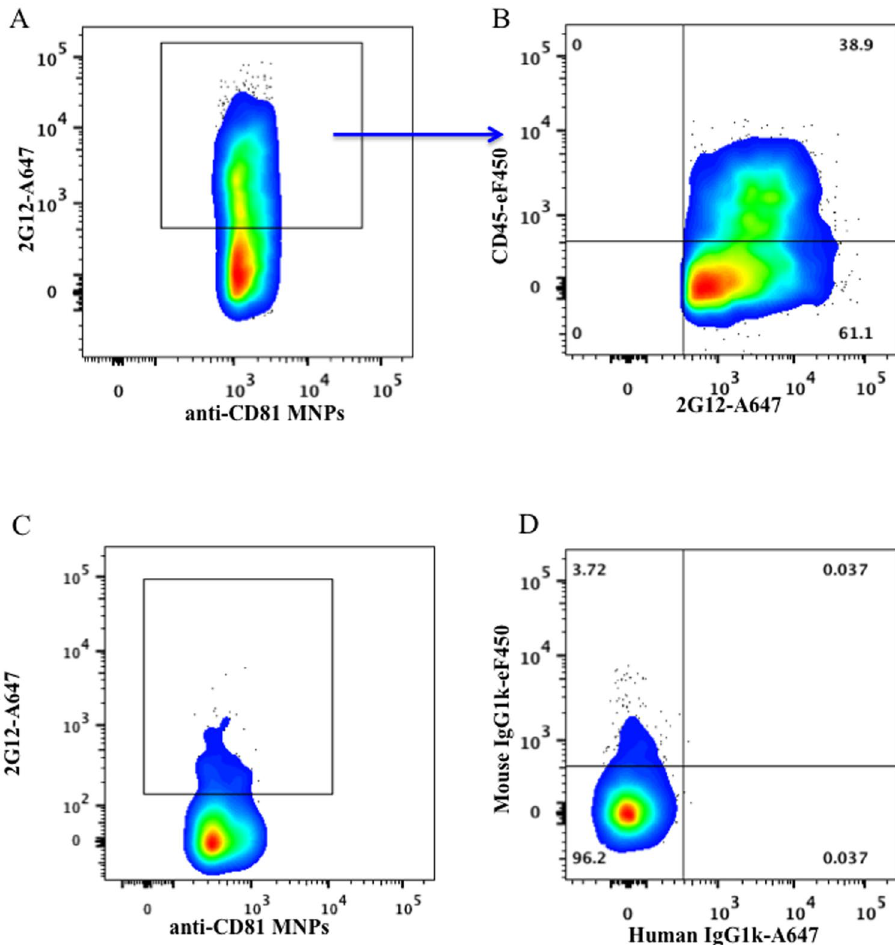
Figure 1. Analysis of EVs and HIV-1 captured with CD81 MNPs. A preparation of HIV SF162 (containing both viruses and EVs) was incubated with CD81 MNPs and the captured particles were stained for CD45 with anti- CD45-eFluor 450 and for gp120 with 2G12-Alexa Fluor 647 antibodies. ( A ) Particles (EVs and/or virions) captured with CD81 MNPs carrying gp120. ( B ) EVs (CD45 + ) captured with CD81 MNPs carrying gp120. ( C ) 2G12 specificity control: EVs released by uninfected PBMCs captured with CD81 MNPs negative for 2G12- Alexa Fuor 647. ( D ) Isotype control: Staining with mouse IgG1k-eFluor 450 and human IgG1k-Alexa Fluor 647 antibodies. Presented are data from one representative experiment out of